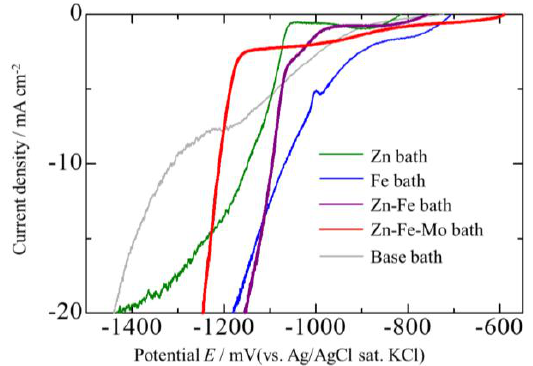
Figure 5. Cathodic polarization curves obtained from different baths.